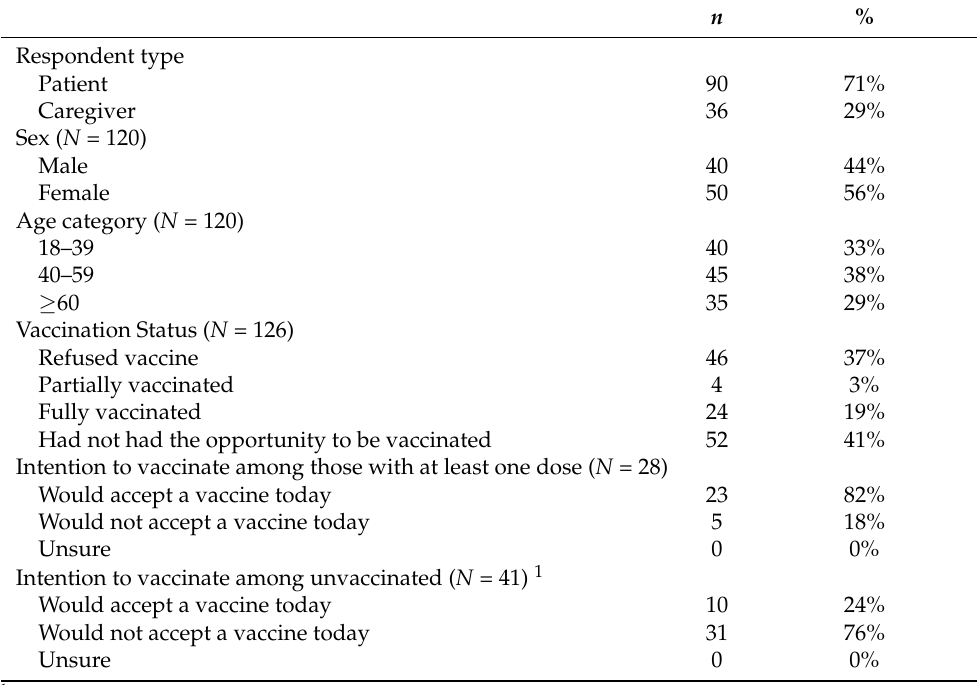
Table 1. Characteristics of survey respondents and outcomes ( N =